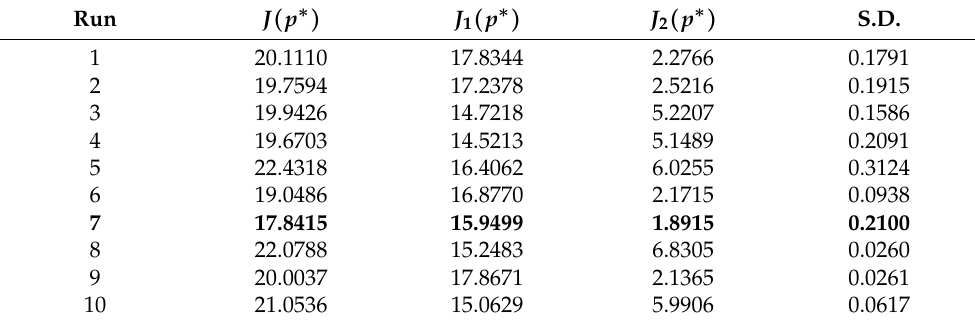
Table 4. The best results of each algorithm execution. The solution marked in boldface represents the best among